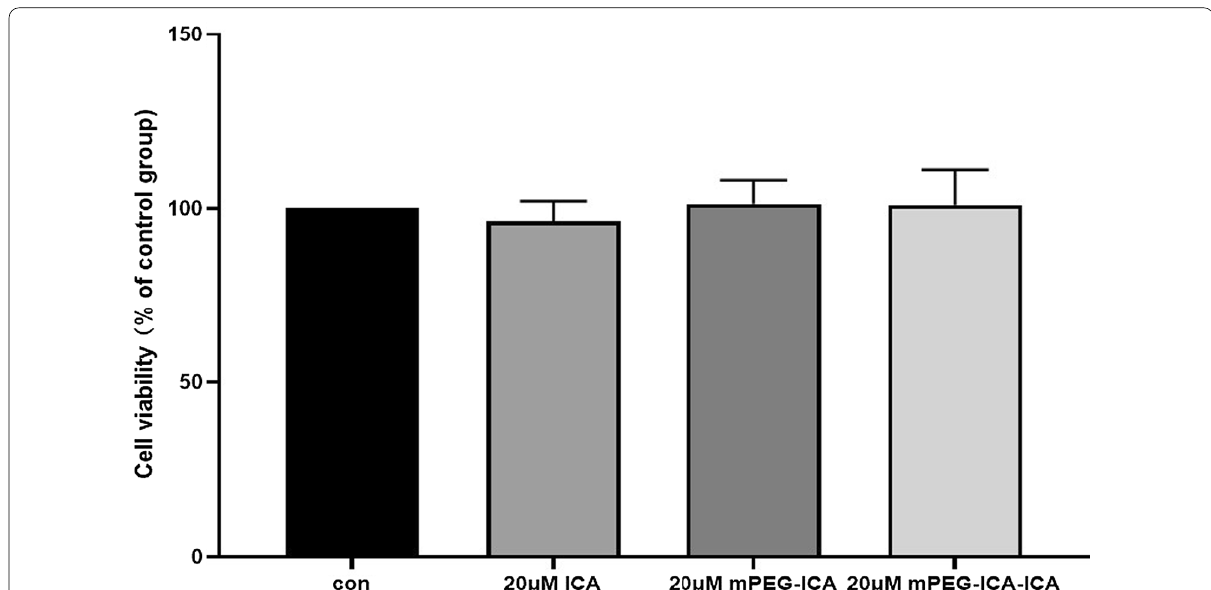
Fig. 5 Evaluation of the cytotoxicity of ICA nanoparticles on H9c2 cells. Data are expressed as the mean